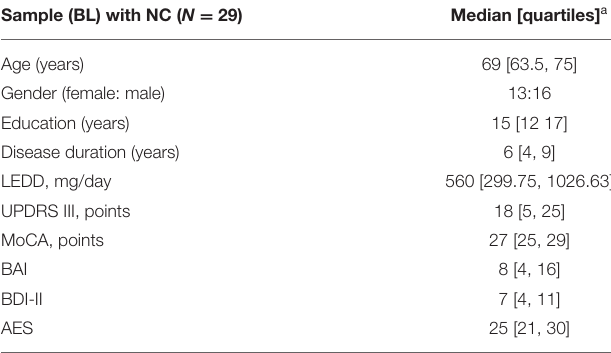
TABLE 1 | Participant’s characteristics at Baseline.